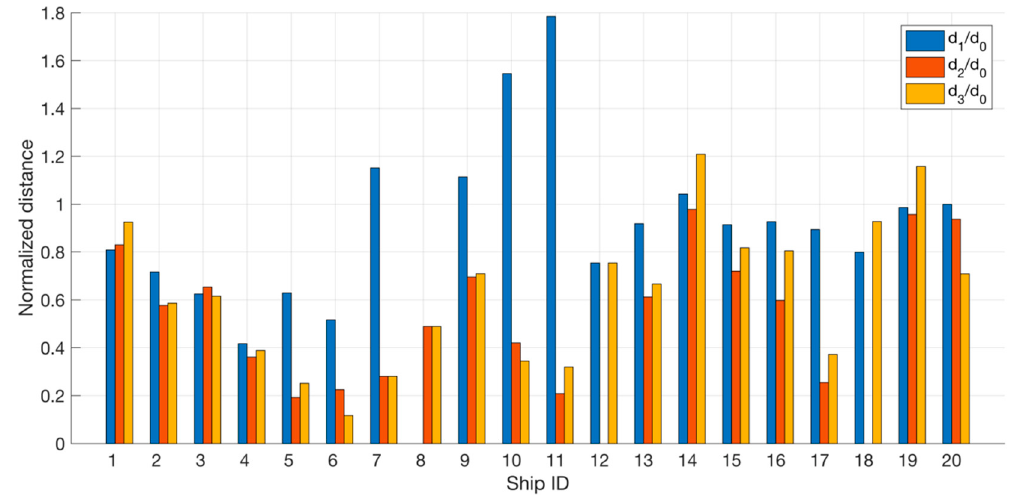
Figure 7. Comparison between AIS-based and SAR-based data matching.